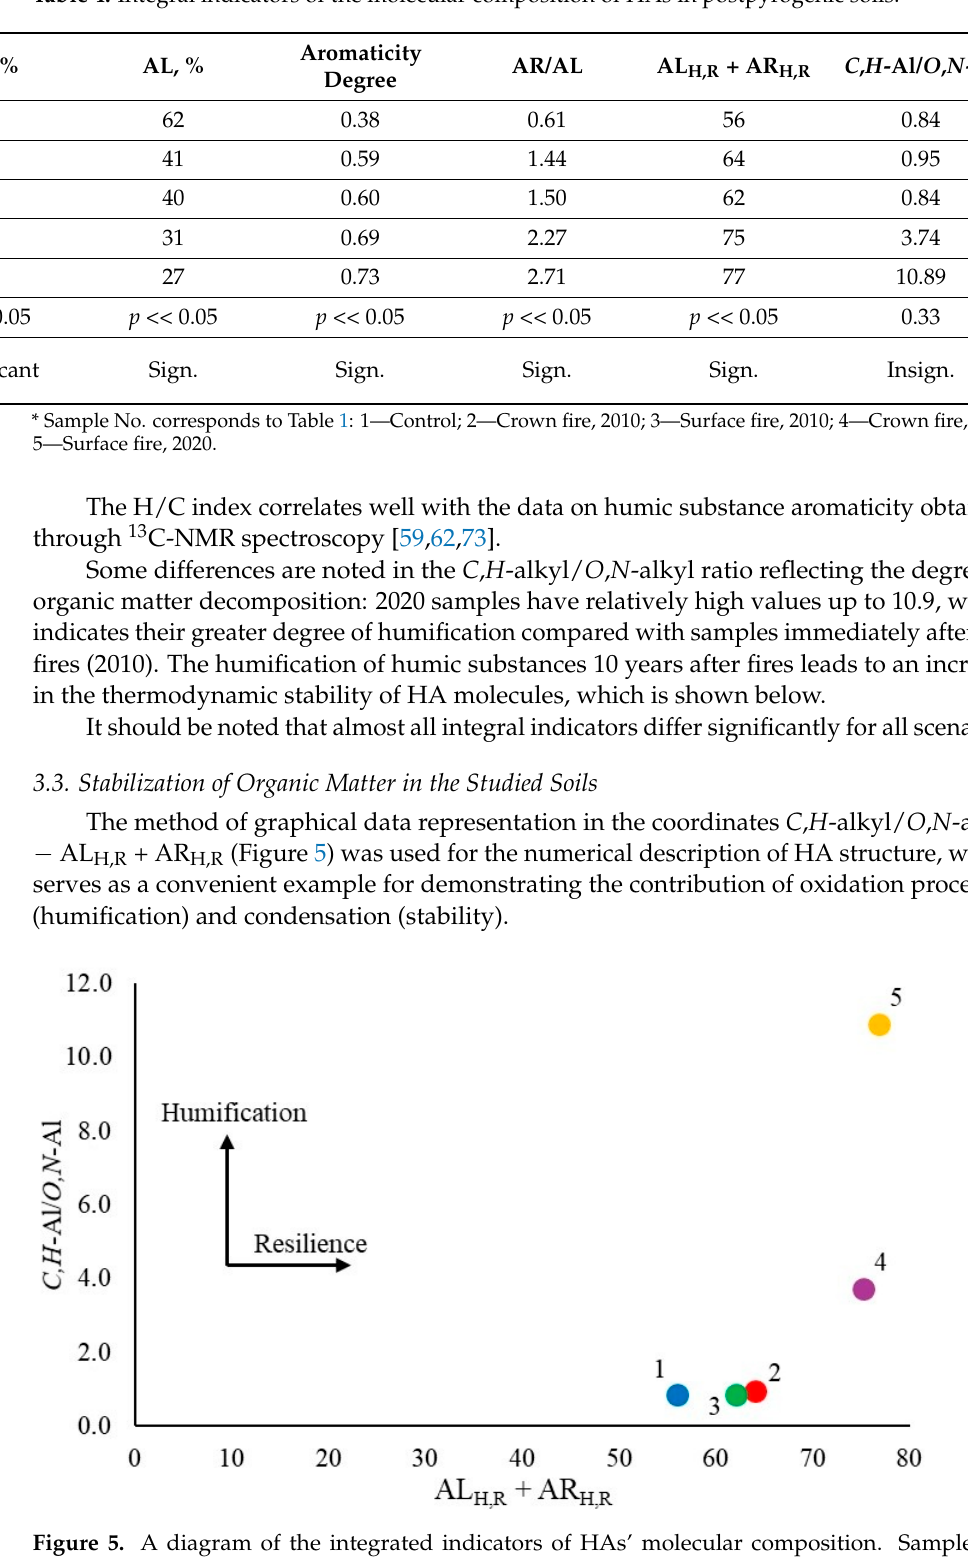
Table 4. Integral indicators of the molecular composition of HAs in postpyrogenic soils.